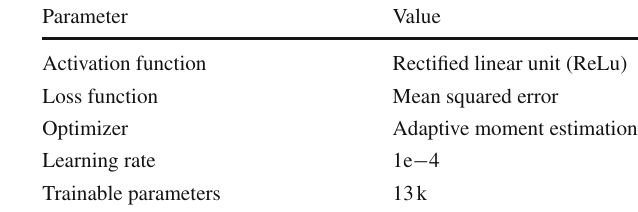
Table 3 Hyperparameters for the autoencoder